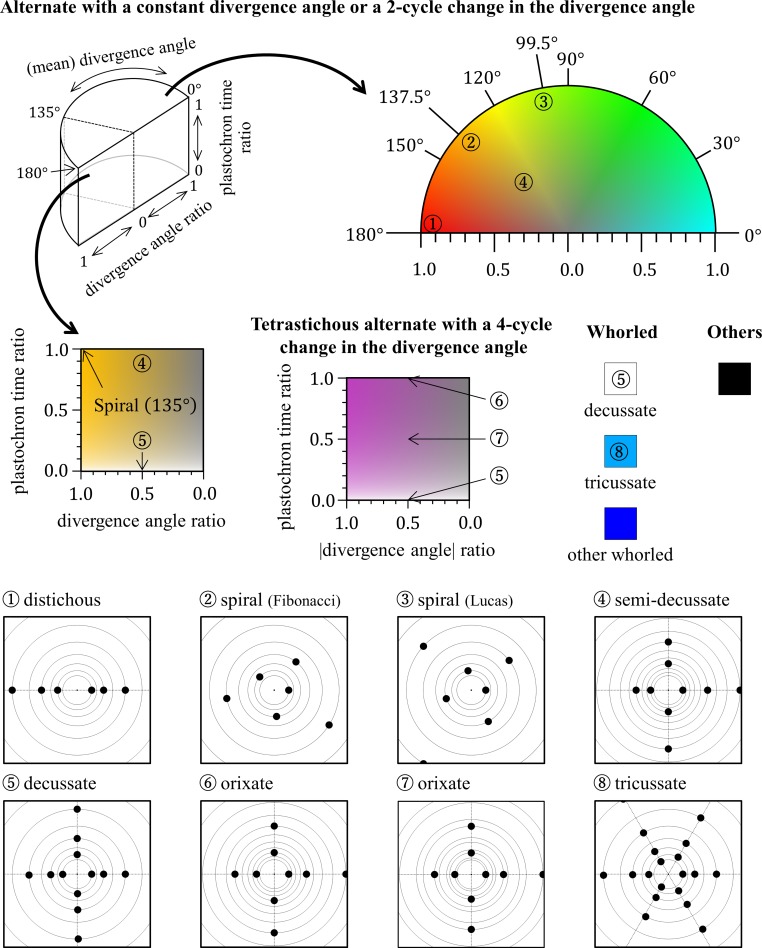
Color legend for the phyllotactic patterns generated in computer simulations.The phyllotactic patterns generated in computer simulations were classified into an alternate pattern with a constant divergence angle or a two-cycle change in the divergence angle; a tetrastichous alternate pattern with a four-cycle change in the divergence angle; a whorled pattern; and other patterns. Whorled patterns were further classified into decussate (“opposite phyllotaxis” typified by true decussate), tricussate, and other whorled patterns. These patterns were distinguished using different colors. For regular alternate patterns with a constant divergence angle, the divergence angle was indicated by a color hue from cyan (0°) to red (180°). In the case of alternate patterns with a two-cycle divergence angle change, the color hue was assigned for the mean value of the successive divergence angles. In these two-cycle alternate patterns, small-to-large ratios of two successive plastochron times and two successive divergence angles were represented by lightness (full lightness for 0) and saturation (full saturation for 1), respectively. Tetrastichous alternate patterns with a four-cycle divergence angle change were similarly expressed by color brightness and saturation based on their ratios of plastochron times and divergence angles; however, instead of the divergence angles themselves, the absolute values of divergence angles were used to calculate the ratio of divergence angles. As the divergence angle of this type of alternate pattern changes in the sequence of p, q, −p, and −q (−180°<p,q≤180°), |q|/|p| gives the ratio of the absolute values of divergence angles if |p|>|q|. Typical examples of phyllotactic patterns are marked with circled numbers in the color legend and their schematic diagrams are shown at the bottom.